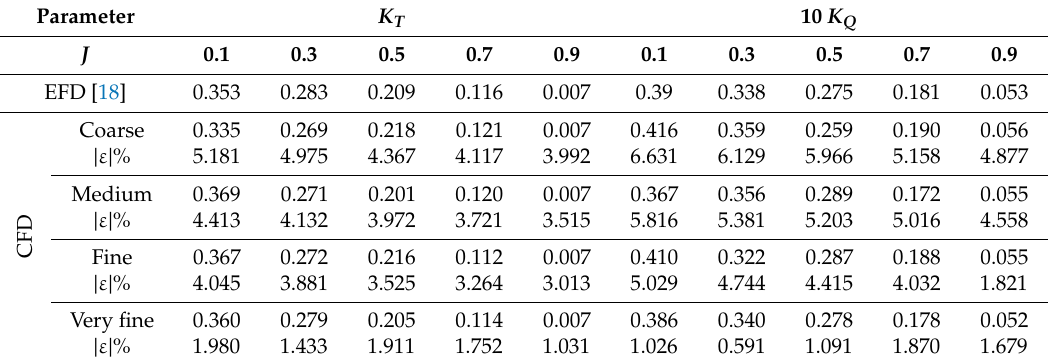
Table 2. Grid convergence test. Experimental data from